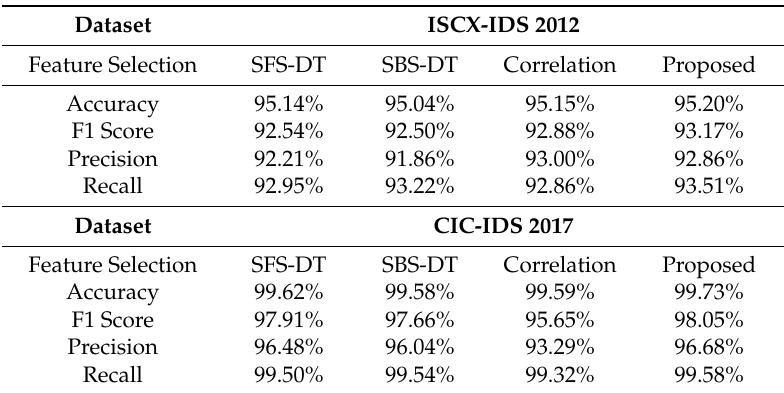
Table 4. Test results of the CIC-IDS 2017 and ISCX-IDS 2012 datasets based on di ff erent feature selection